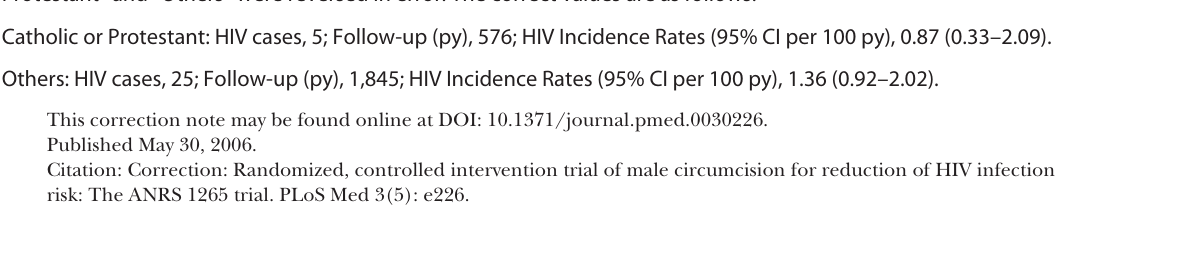
Table 4: Under “Religion,” the values for “HIV cases,” “Follow-up,” and “HIV incidence rates” for the categories “Catholic or Protestant” and “Others” were reversed in error. The correct values are as